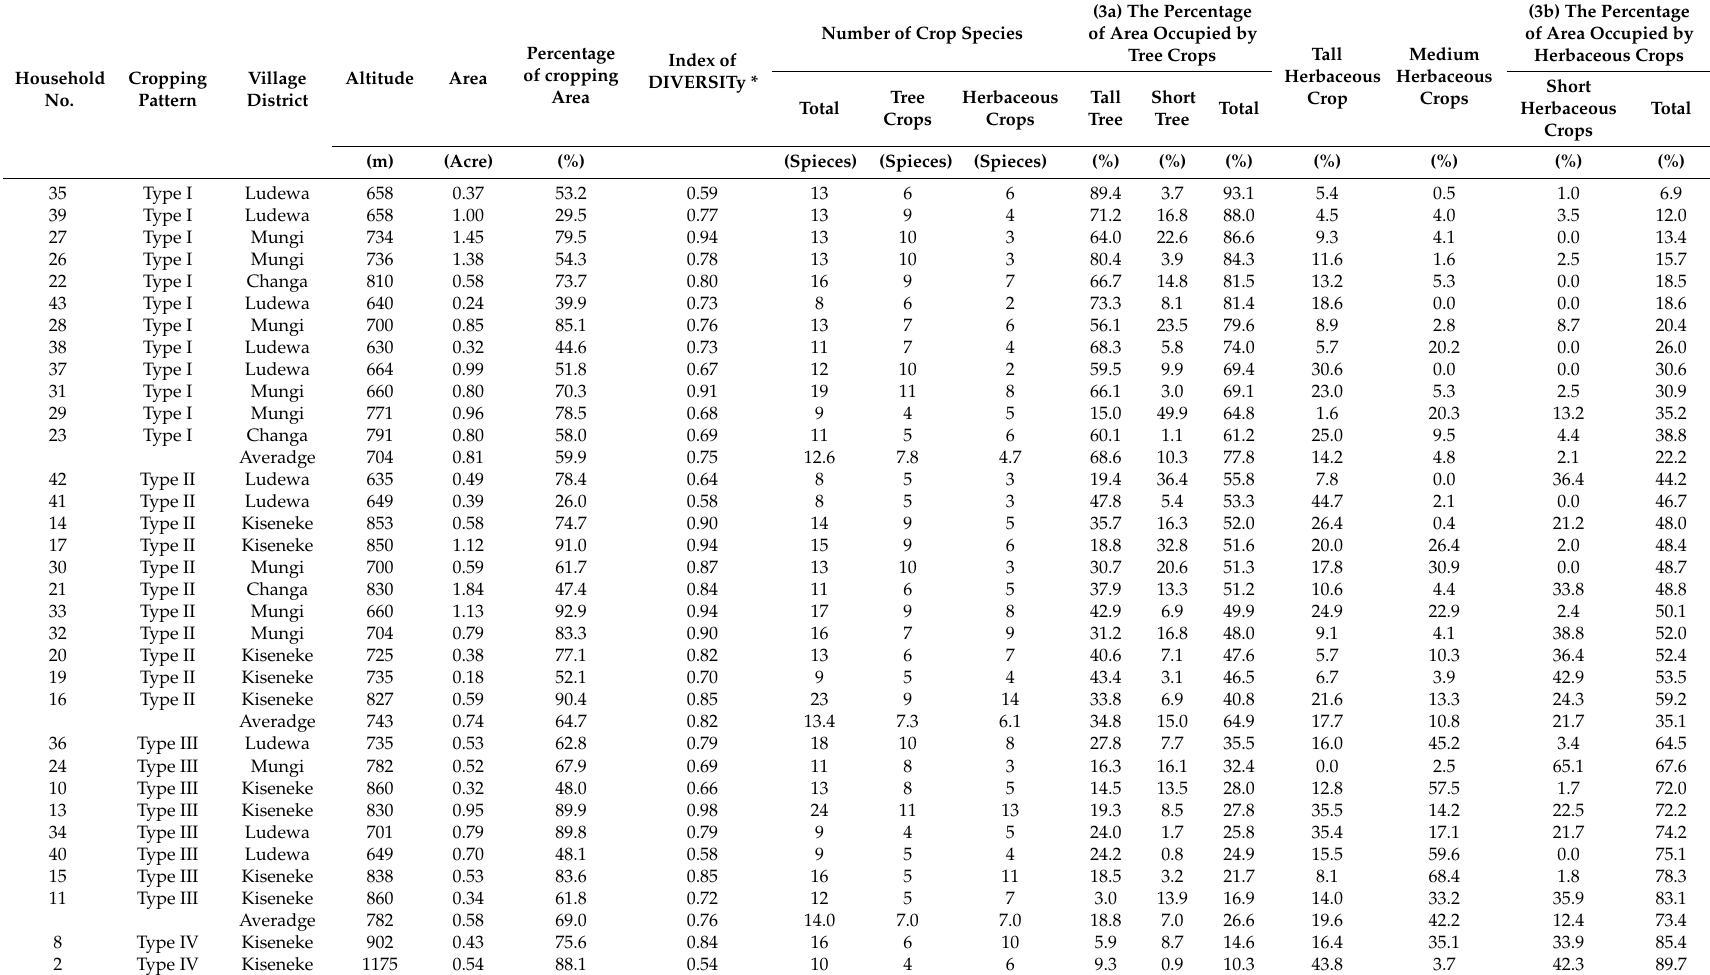
Table 1. Information on the four types of cropping